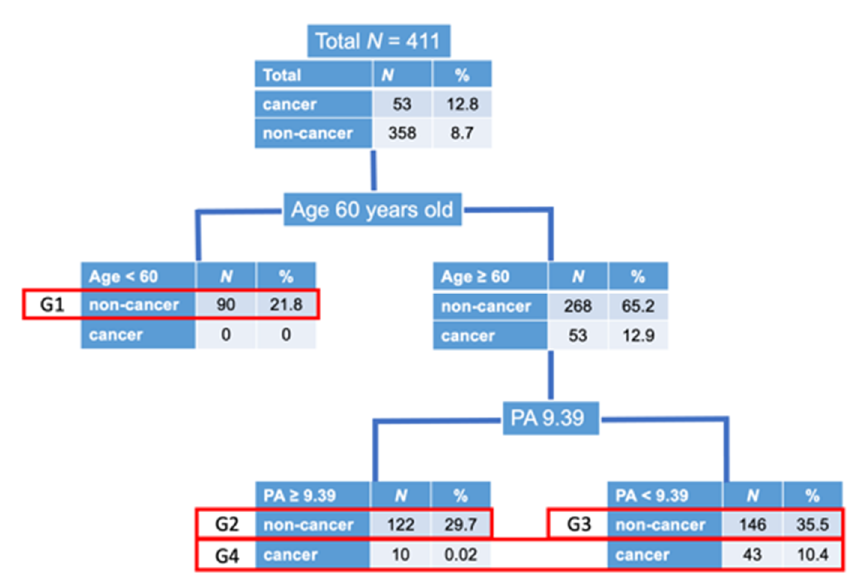
Figure 3. Disposition of patients. As there was no cancer patient in age < 60 years old, we first di- vided the patients into 2 groups according to age of 60 years old. Next, the CART defined that the cut-off value of coronary atherosclerotic plaque area (PA) to divide the patients into with and with- out cancer was 9.39 mm 2 . Then, we divided the patients ≥ 60 years old into 2 groups according to plaque area of 9.39 mm 2 , with and without cancer. Due to the small number of cancer patients, we made 4 groups as shown above. Group 1; non-cancer, age < 60 years old, Group 2; non-cancer, age ≥ 60 years old, plaque area ≥ 9.39 mm 2 , Group 3; non-cancer, age ≥ 60 years old, plaque area < 9.39 mm 2 , Group 4; cancer, age ≥ 60 years old.